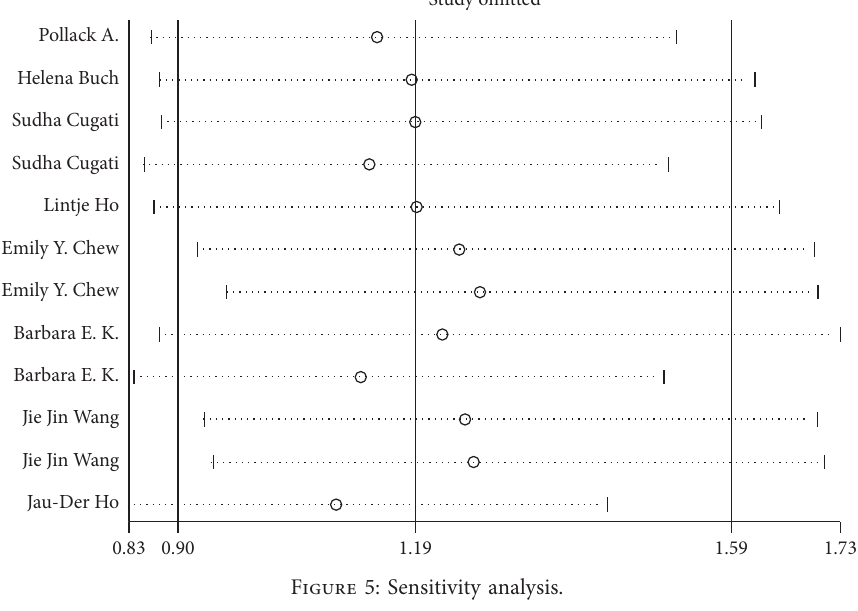
Figure 5: Sensitivity analysis.